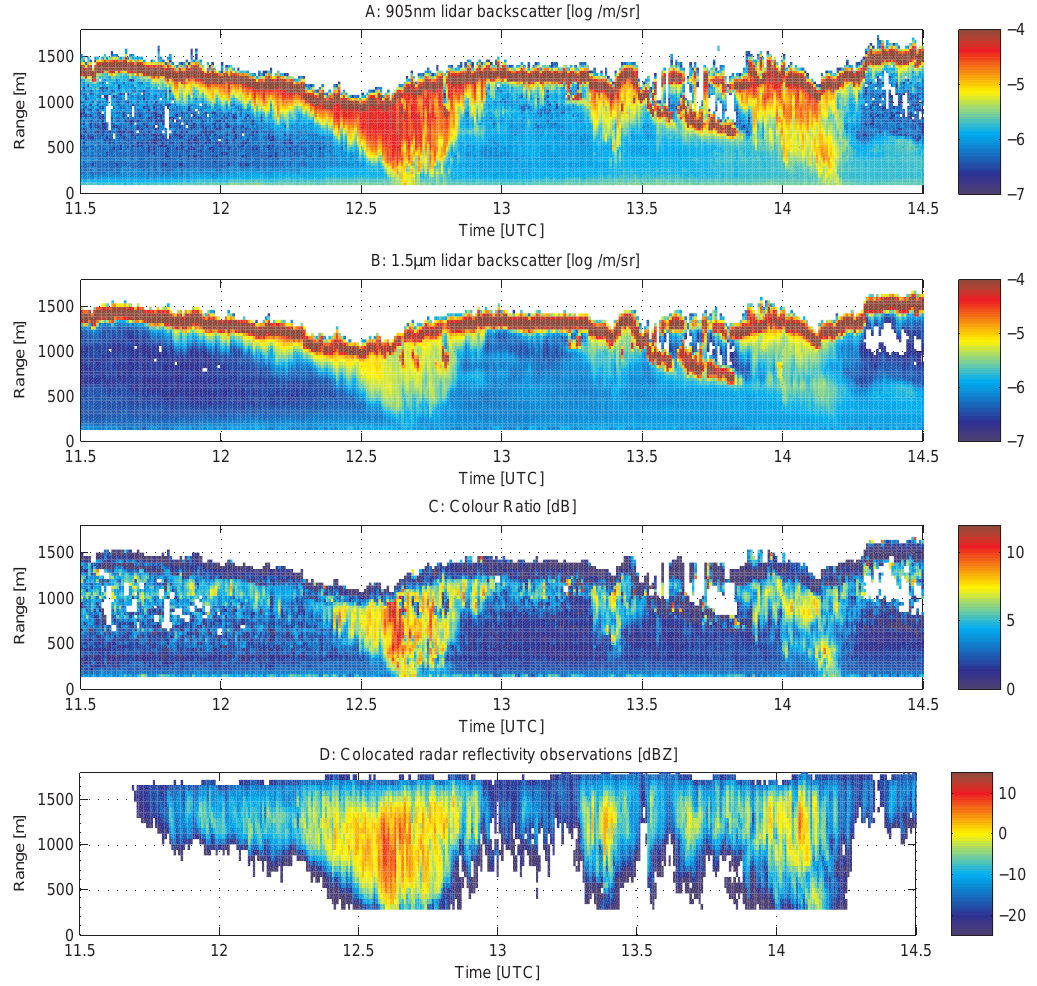
Fig. 6. Lidar and radar observations, 5 November 2007. Panels (A) and (B) show attenuated lidar backscatter observed at 905nm and 1.5µm, respectively. Panel (C) shows the lidar colour ratio. Panel (D) shows reflectivity measurements from colocated cloud radar.